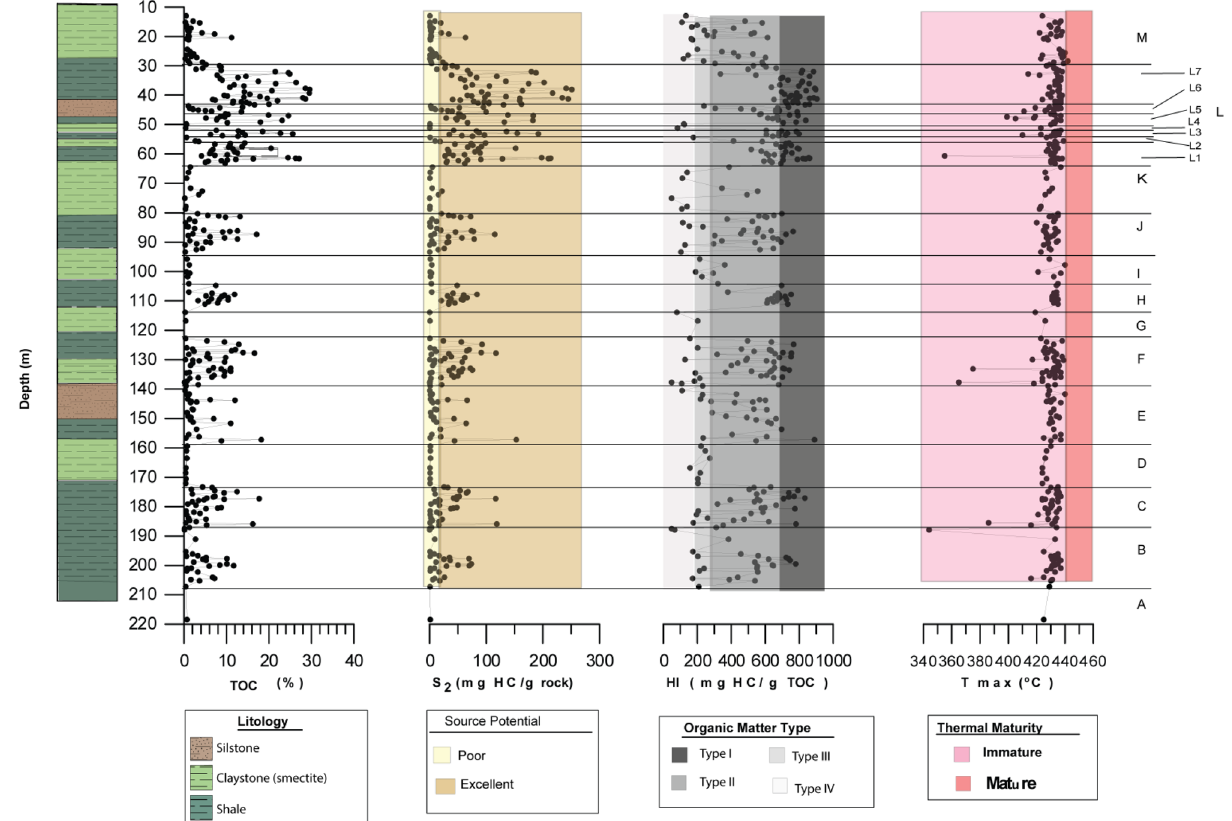
Fig. 3 TOC, S2, HI and Tmax in well TMB-03-SP in Tremembé